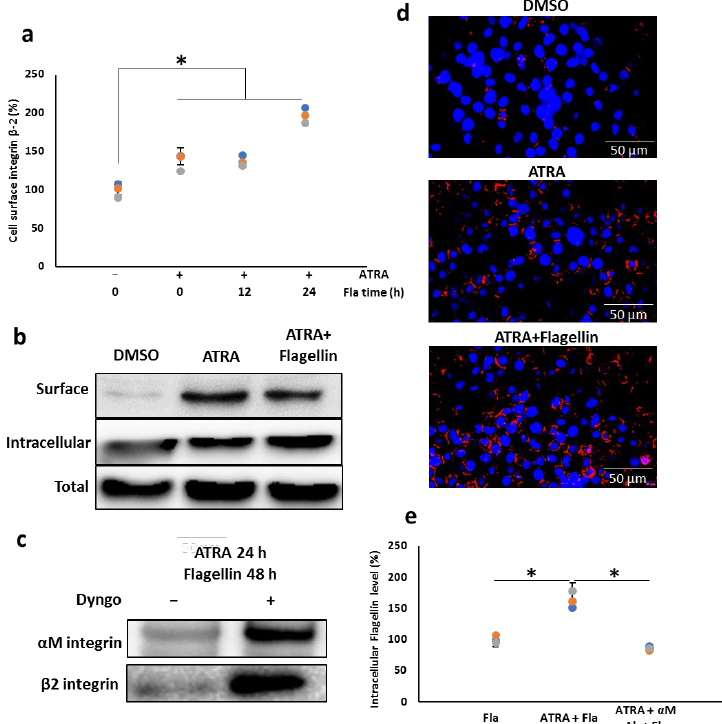
Figure 7. Flagellin enhances the cell surface integrin α M β 2 expression, and the treatment with the anti- α M integrin antibody reverses the ATRA-enhanced flagellin uptake. ( a ) Cell surface levels of integrin β 2 examined by flow cytometry. THP-1 cells were stimulated with 1 µ M ATRA for 24 h followed by treatment with 100 ng/mL flagellin for different time periods, and cell surface integrin β 2 was examined by flow cytometry. ( b ) Integrin β 2 expression examined by Western blot analysis. Cell surface integrin β 2 was purified by biotinylation, and the surface proteins, intracellular proteins or total proteins were subjected to Western blotting. ( c ) Cell surface Hsp90-bound α M/ β 2 examined by Western blot. THP-1 cells were treated with 1 µ M ATRA for 24 h in the presence or absence of 1 µ M dynamin-specific inhibitor Dyngo ® followed by 48 h treatment with flagellin. The cell surface protein was biotinylated, immunoprecipitated with anti-Hsp90 antibody and immunoblotted with anti- α M/ β 2 integrin antibodies. ( d ) Intracellular integrin β 2 expression examined by fluorescence microscope. To detect intracellular integrin β 2, the collected cells were fixed with formaldehyde, permeabilized with Triton X-100 and incubated with the anti-integrin β 2 antibody overnight at 4 ◦ C. After subsequent incubation with the Alexa 633-conjugated secondary antibody and Hoechst33342 staining dye for nucleus, the level of integrin β 2 was detected by fluorescence microscope ( × 200). Scale bars represent 50 µ m. ( e ) Intracellular integrin β 2 expression examined by flow cytometry. THP-1 cells were stimulated with 1 µ M ATRA for 24 h, followed by 2 h treatment with 1 µ g/mL anti- α M integrin antibody prior to treatment with 100 ng/mL flagellin for 24 h. The intracellular level of flagellin was measured by flow cytometry. * p <